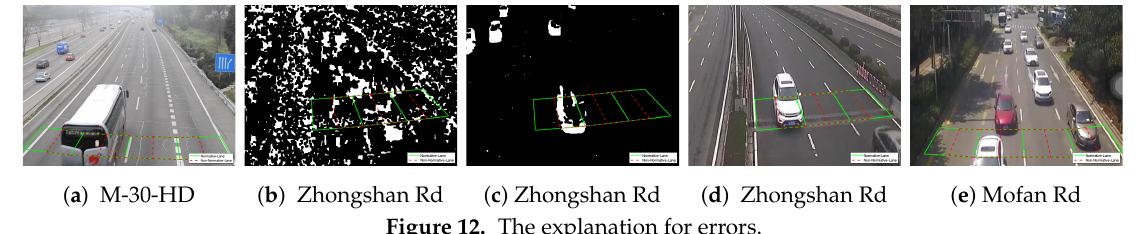
Figure 12. The explanation for errors.